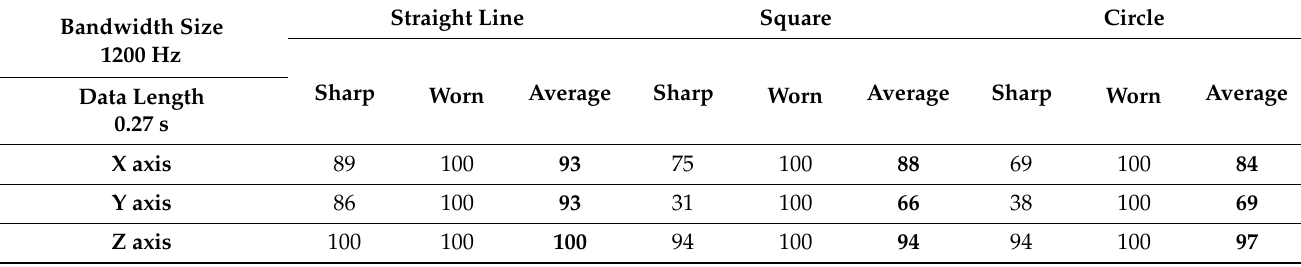
Table 2. Tool wear classification rate with various axis vibration signals (model trained by line data).